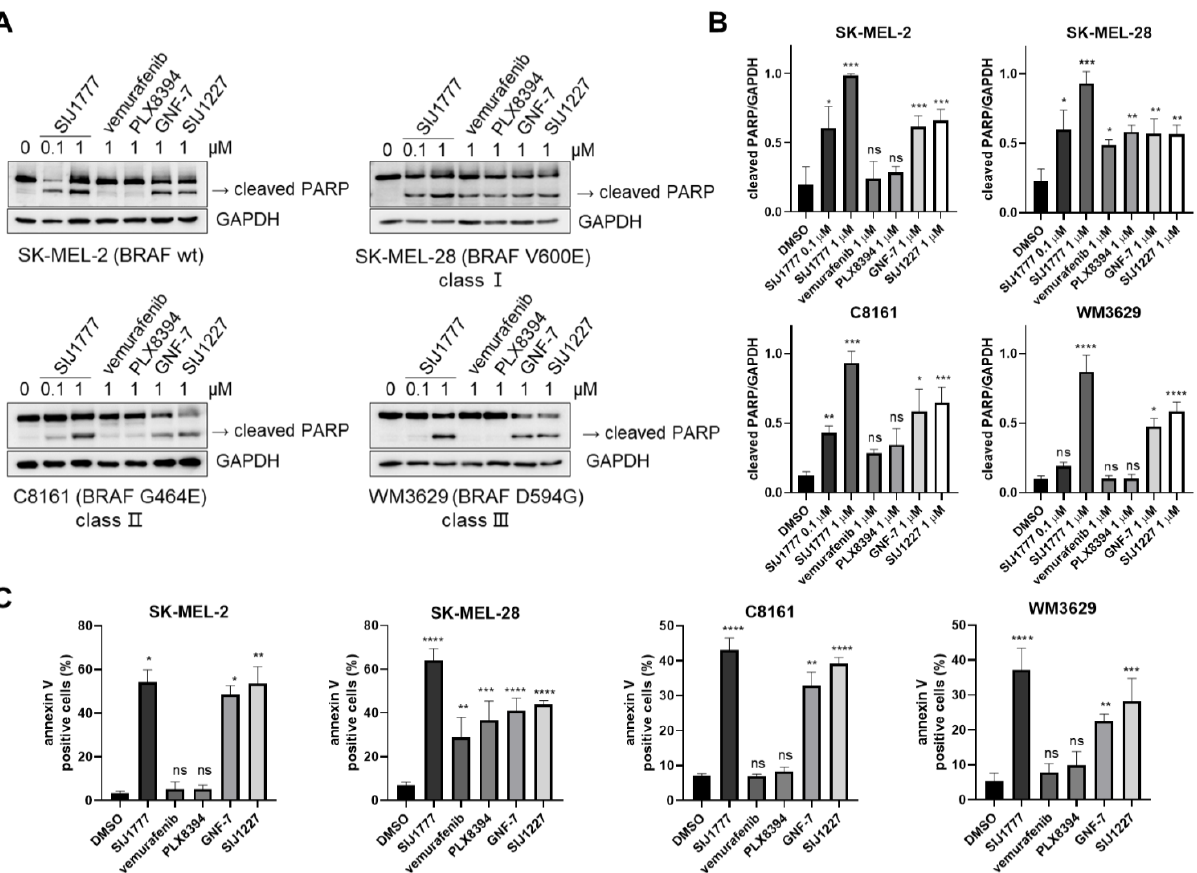
Figure 4. The effect of SIJ1777 on apoptosis induction. ( A ) Western blot for pro-apoptotic marker level (cleaved PARP) in melanoma cell lines. GAPDH was used as the internal loading control. ( B ) Quantification graphs of western blot results by ImageJ ( n = 3). ( C ) Apoptotic cell (annexin V-positive) population was measured by flow cytometry analysis against melanoma cell lines ( n = 3). Cells were treated with indicated substances for 24 h. Statistical significances were determined using a one-way ANOVA analysis (* p < 0.05, ** p < 0.01, *** p < 0.001, **** p < 0.0001).